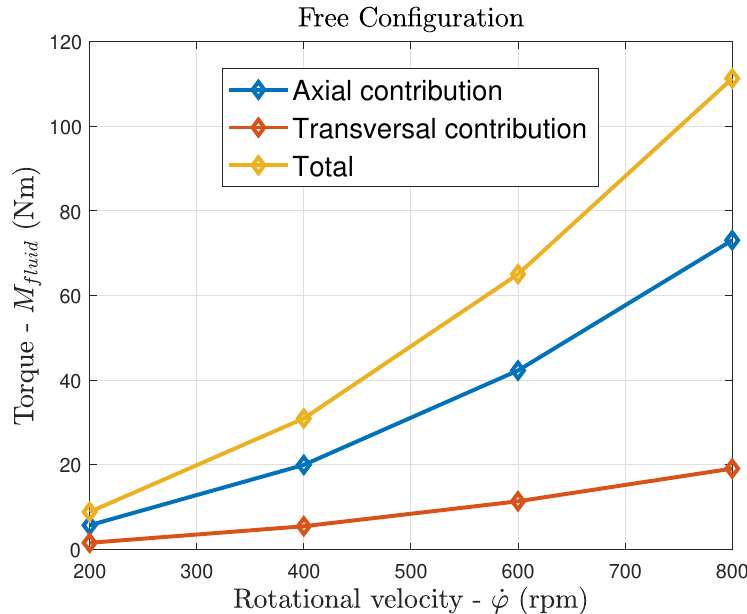
Figure 7. Total fluid friction torque as a function of the rotational velocity without